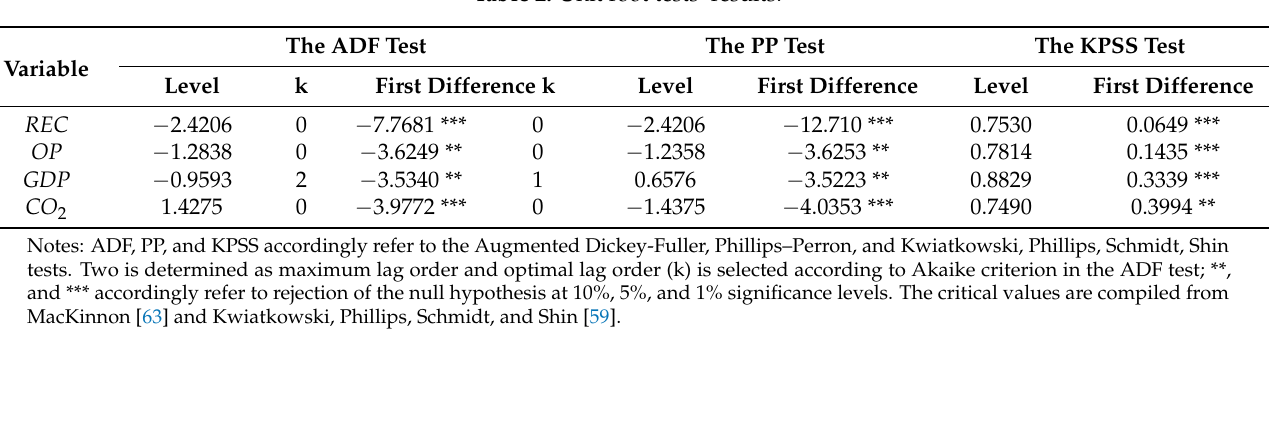
Table 2. Unit root tests’